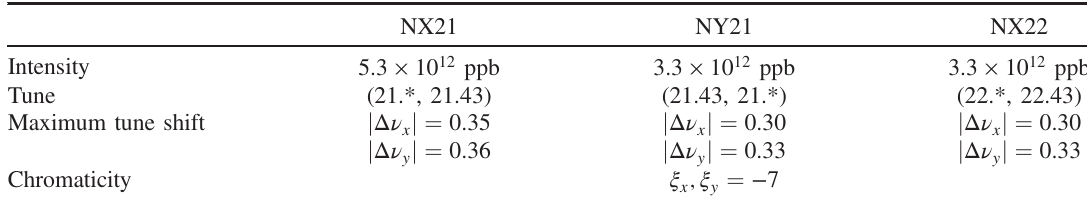
TABLE II. Conditions of the measurements. The beam intensities were measured by the direct-current